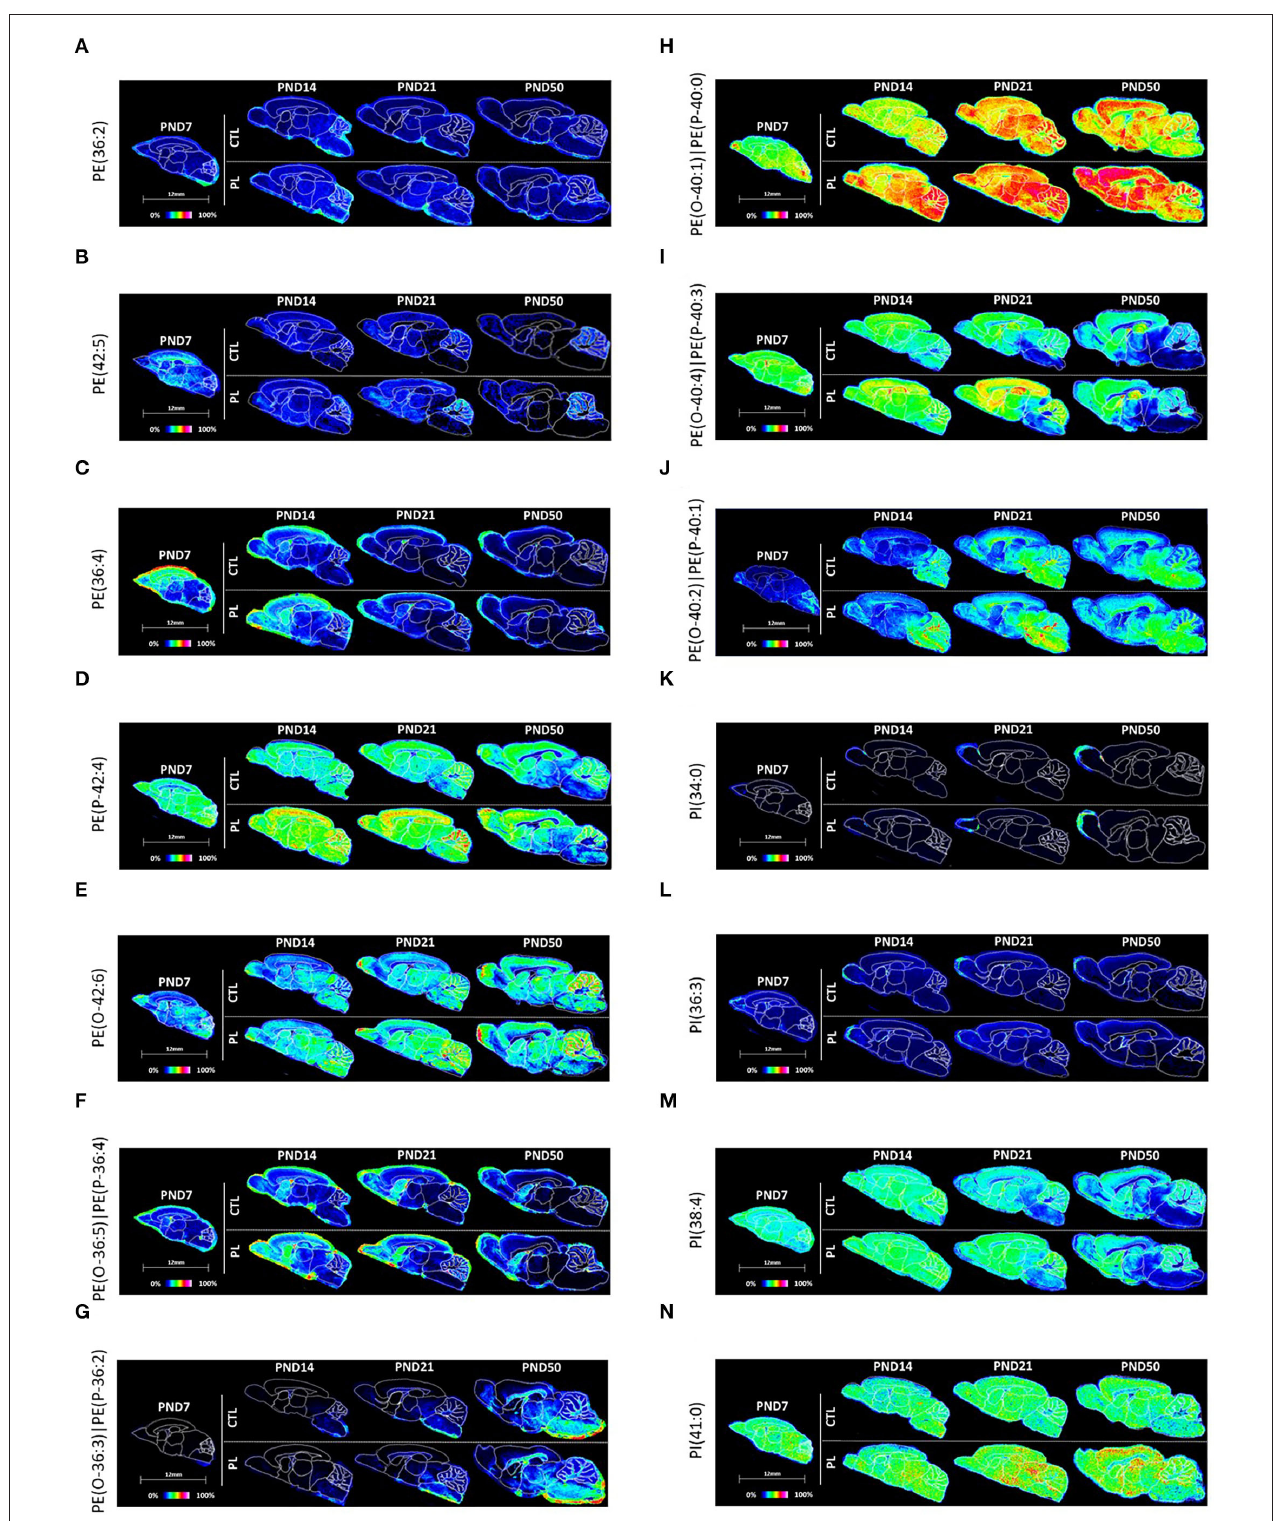
FIGURE 7 | Spatiotemporal distribution of glycerophospholipids. Representative MALDI-MSI images are shown for (A–J) phosphoethanolamines and (K–N) phosphoinositol. Control sections are presented on the top. PL-supplemented sections are presented on the bottom. The age is indicated above the images. The signal intensity scale is normalized to 100% of maximum peak intensity across all images.